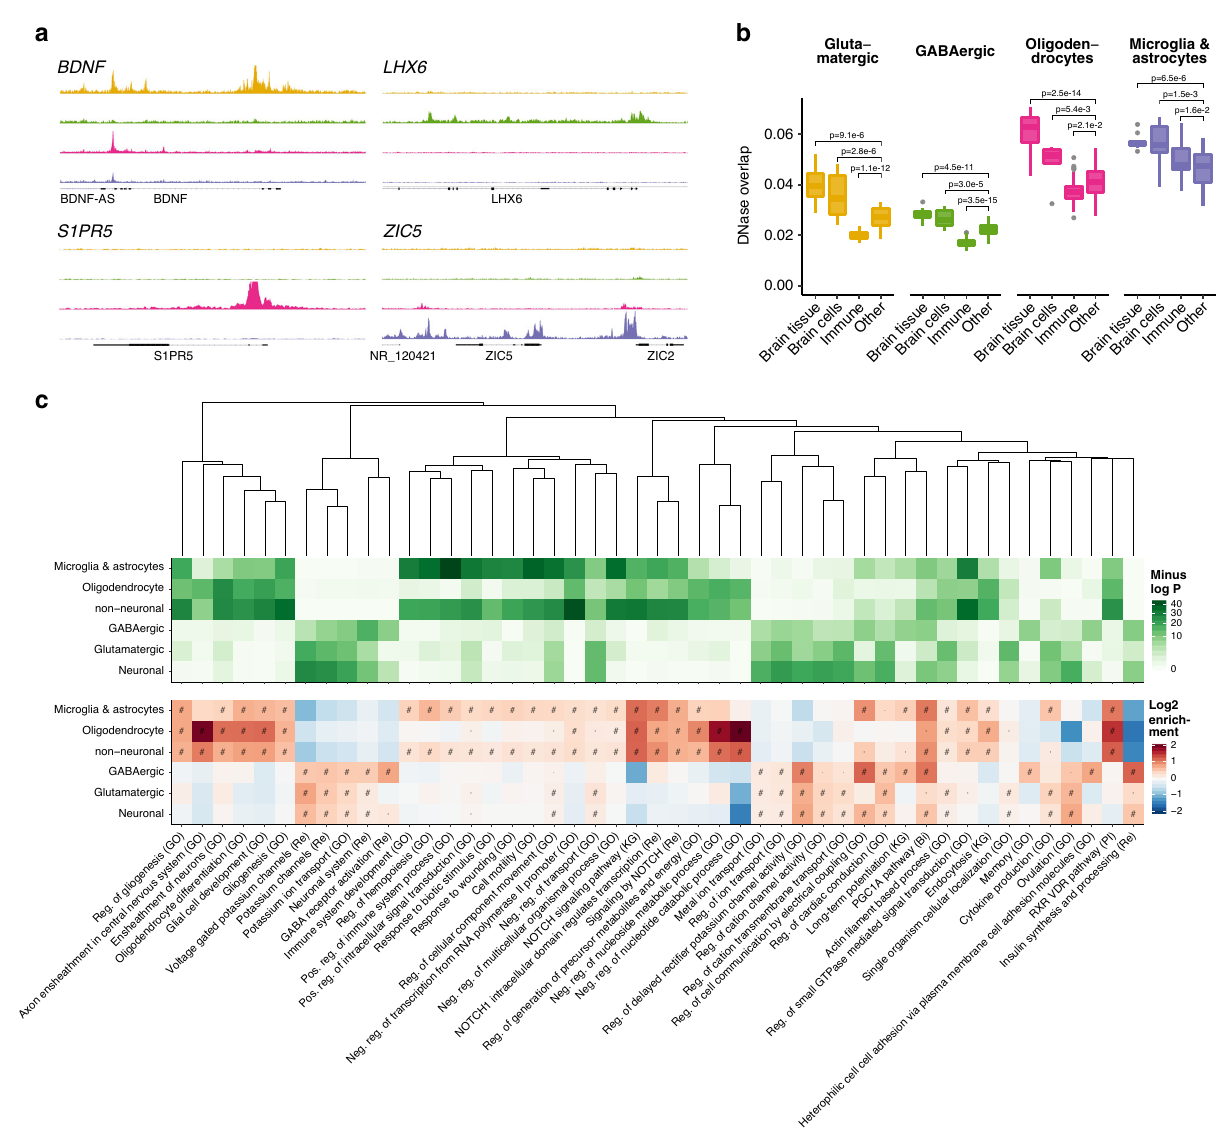
Fig. 2 Cell-speci fi c OCRs, overlap with DNAse-seq, and biological functions. a Examples of genes with cell-speci fi c open chromatin. Cell types from top to bottom are; glutamatergic neurons, GABAergic neurons, oligodendrocytes, and microglia/astrocytes. b Overlap between cell-speci fi c open chromatin (ATAC-seq) and 127 samples from REMC (DNase-seq). The overlap was calculated by the Jaccard index of the base pair overlap. Samples from REMC were aggregated into four groups: brain tissue, brain-derived cells, immune cells/tissues, and other non-brain cells/tissues. The center shows the median, the box shows the interquartile range, whiskers indicate the highest/lowest values within 1.5x the interquartile range, and outliers from this are shown as dots. The number of independent sample overlaps represented by the boxplot groups are as follows: Brain tissue: 10, Brain cells: 6, Immune: 30, and Other: 81. To assess the signi fi cance of the differences in overlap for our cell-speci fi c OCRs with the four REMC categories, a multiple regression analysis with the “ Other ” category as the intercept was done. P -values indicate signi fi cance of enrichment/depletion against the other category uncorrected for multiple testing. c Overlap between cell-speci fi c open chromatin (ATAC-seq) and gene sets representing biological processes and pathways. Only those that were within the top ten most signi fi cant gene sets in one or more ATAC-seq categories are shown. Pathways were clustered by the Jaccard index using the WardD method. “ # ” : one-sided binomial FDR < 0.001, “ · ” : one-sided binomial FDR < 0.05, “ Bi ” : BIOCARTA, “ GO ” : gene ontology, “ KG ” : KEGG, “ Re ” : REACTOME, “ Reg. ” : regulation, “ Pos. ” positive, “ Neg. ”